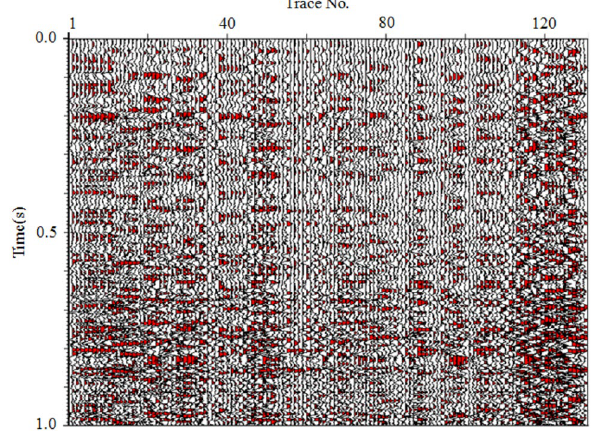
Fig. 7 Denoised section via SVD filtering. The first ten singular val- ues are used. The background noise is eliminated completely, but a little loss of geological details occurred